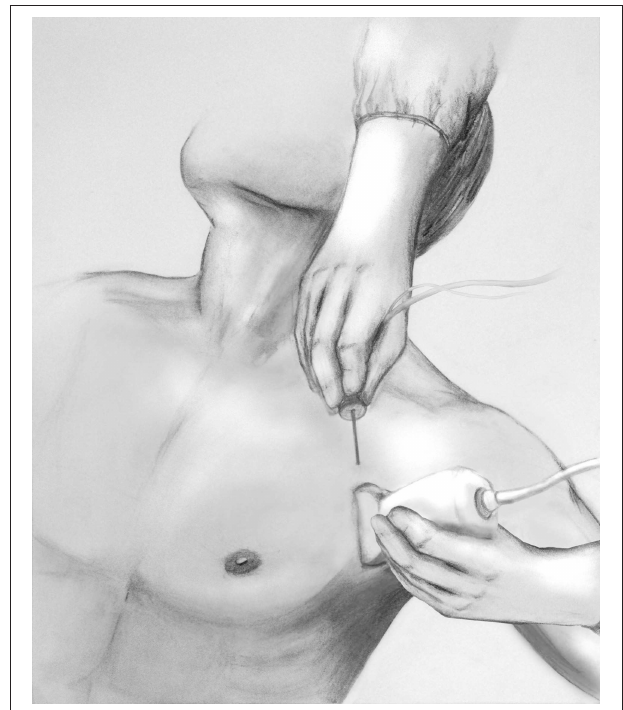
FIGURE 1 | Transducer position and needle insertion point for PECS I and II